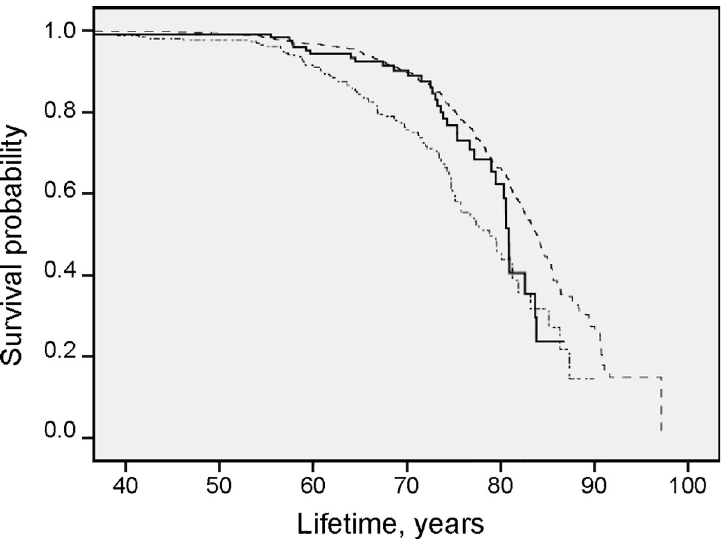
Fig 2. High all-cause mortality in female smokers. Survival probability for all-cause mortality in female smokers ( � ─ � � ─ � � ─ � ), former smokers ( ────── ) and nonsmokers (-—-—-—-) illustrated with results from Kaplan-Meier